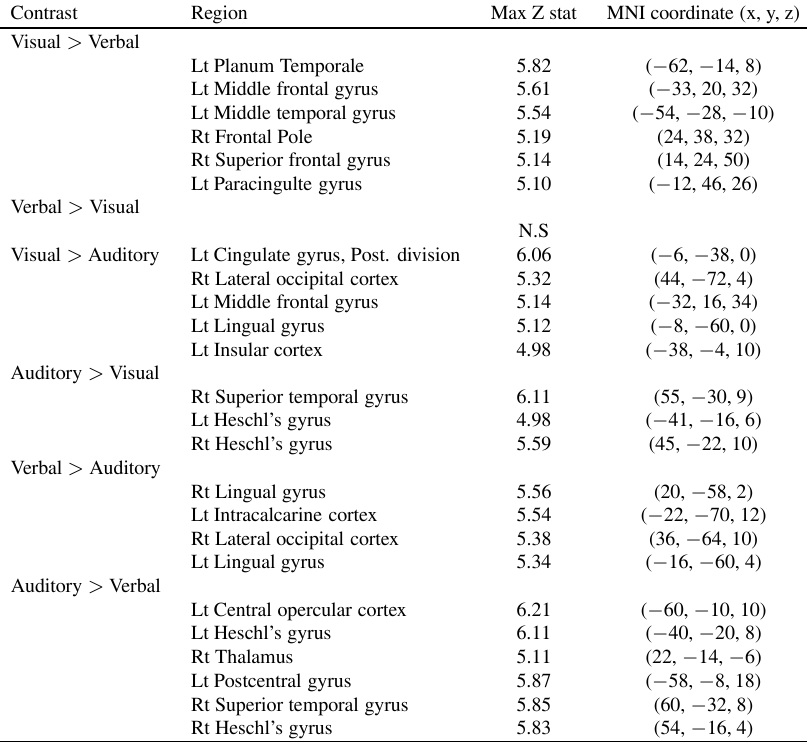
Table 2 Comparison of activations between the tasks; regardless of